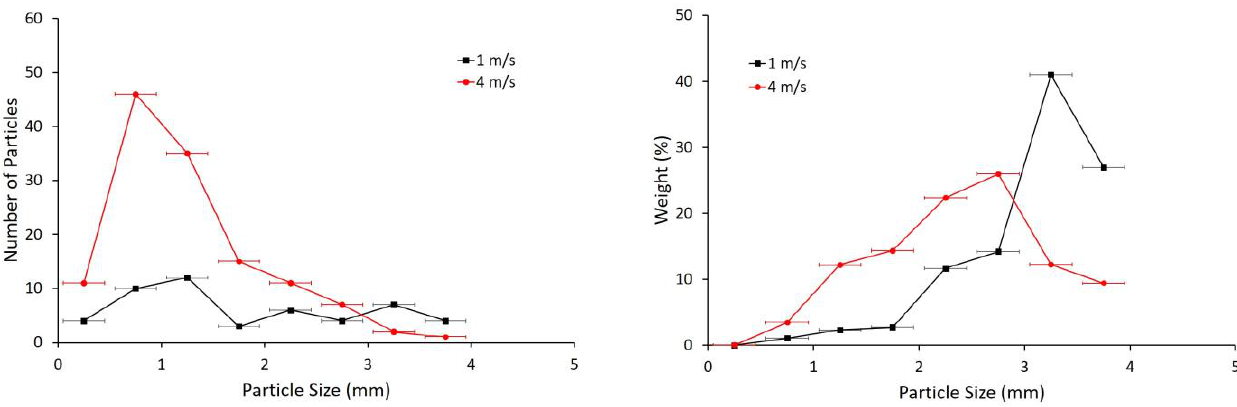
Figure 15. BLS particle shape and size by plotting iso-surface and mesh grid (mesh size = 0.25 mm).